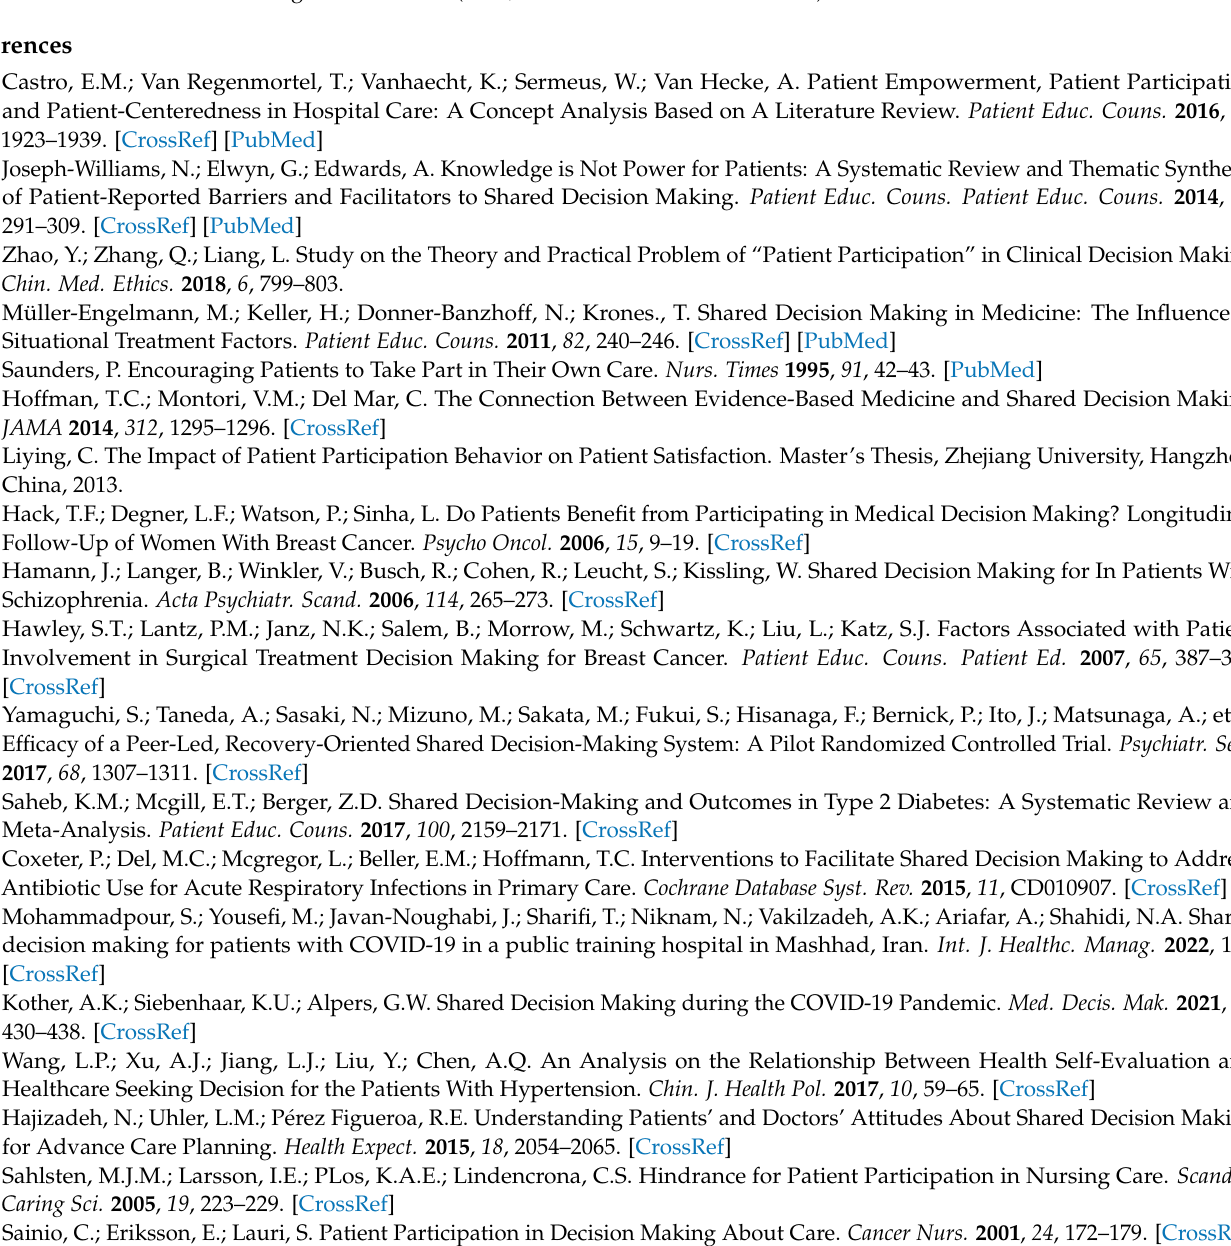
Figure A4. The best-worst scores for respondents in different departments on four statistically significant factors (SBW, standardized best-worst